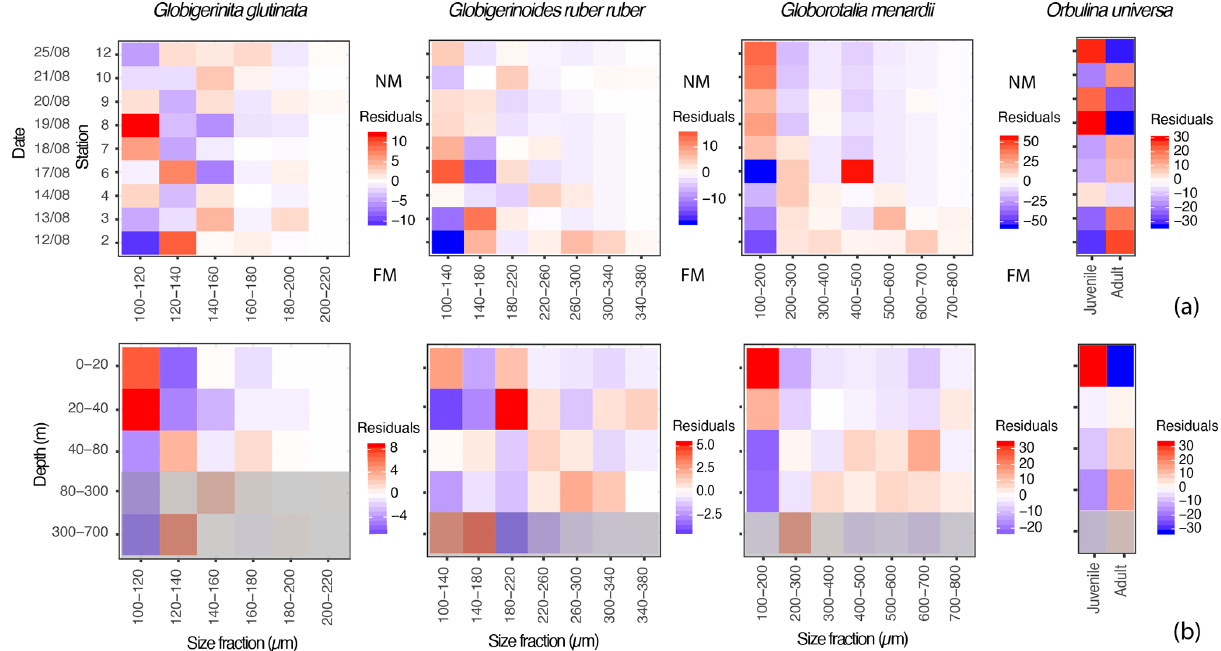
Figure 5. Proportions of specimens of the three studied species of planktonic foraminifera expressed as residuals, highlighting size classes that are overrepresented (red tones) or underrepresented (blue tones) for specific (a) days ( y axis) in comparison to the whole dataset, with FM and NM highlighting the time of the full moon (21 August) and of the new moon (before the sampling started, on the 7 August); and (b) depth intervals ( y axis) in comparison to the whole dataset. The grey filter indicates the depths where > 50% of the specimens were dead (empty shells), and the intercepted filled shells therefore likely represent background mortality across the different size fractions (Peeters and Brummer,